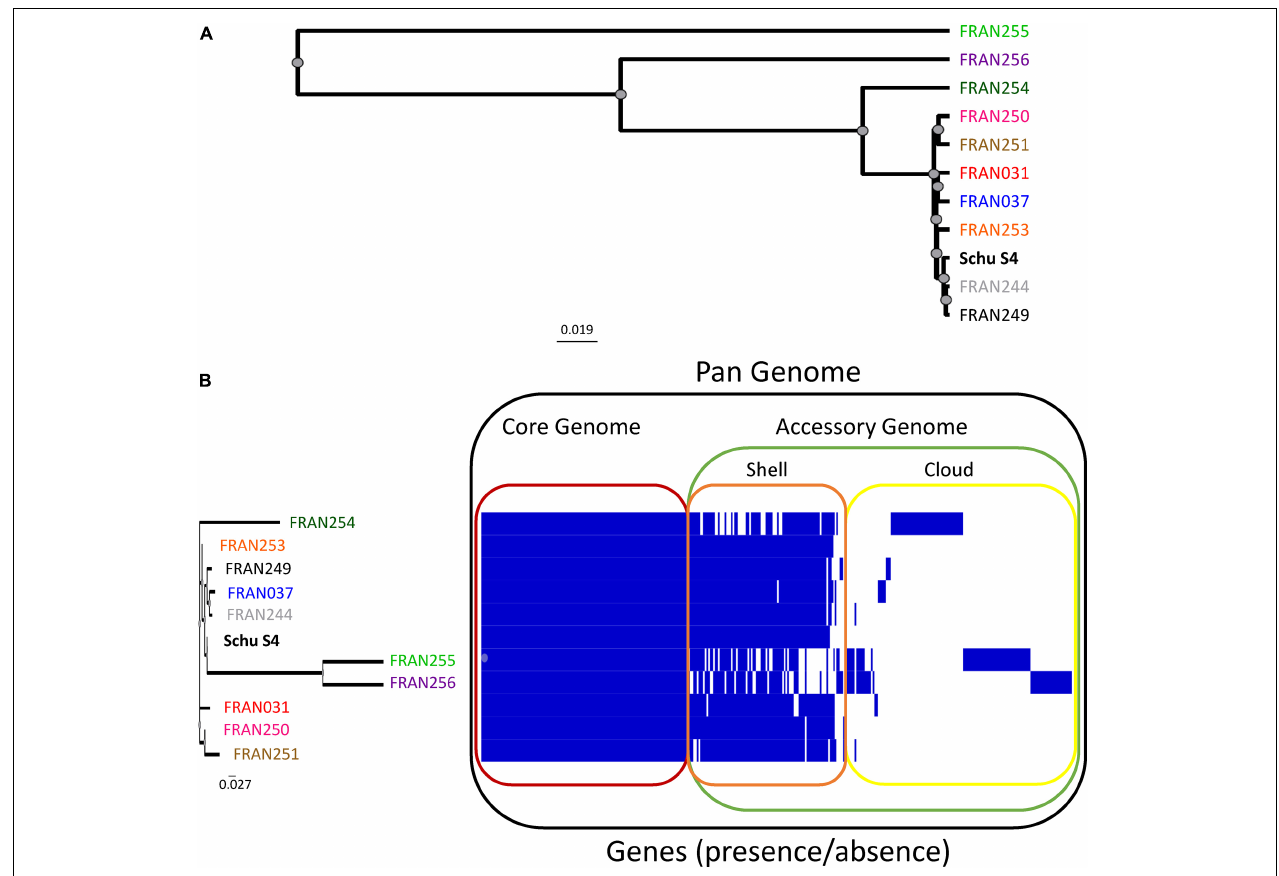
FIGURE 1 | Genomic diversity and pan-genome analysis of the selected F. tularensis panel. (A) A distance tree was generated based upon the average nucleotide identity calculated for the entire genomes of our 10 strain panel and the original Schu S4 sequence (Larsson et al., 2005). The tree indicates clustering of sample matrix by unweighted pair-group method with arithmetic mean (UPGMA). (B) Presence/absence of all genes were assessed across the 11 genomes using Roary, and results were visualized using Phandango. Blue bars indicate the presence or absence of a specific gene across the panel, with genes shared across all strains outlined in red (core genome), genes conserved among most strains outlined in orange (shell), and poorly conserved genes outlined in yellow (cloud). The shell and cloud genes make up the accessory genome (green). The dendrogram based upon the accessory genome of strains in this panel is shown to the left. F. tularensis panel strains are color-coded here and in subsequent figures as follows: FRAN249 - black, FRAN244 - gray, FRAN031 - red, FRAN037 - blue, FRAN255 - green, FRAN256 - purple, FRAN250 - pink, FRAN251 - brown, FRAN253 - orange, FRAN254 - dark green.